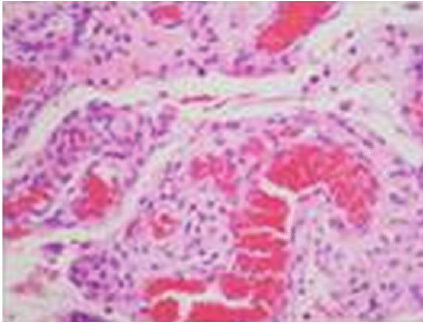
Figure 4: Resection of the leiomyomas. The patient had a correct evolution without any postoperative